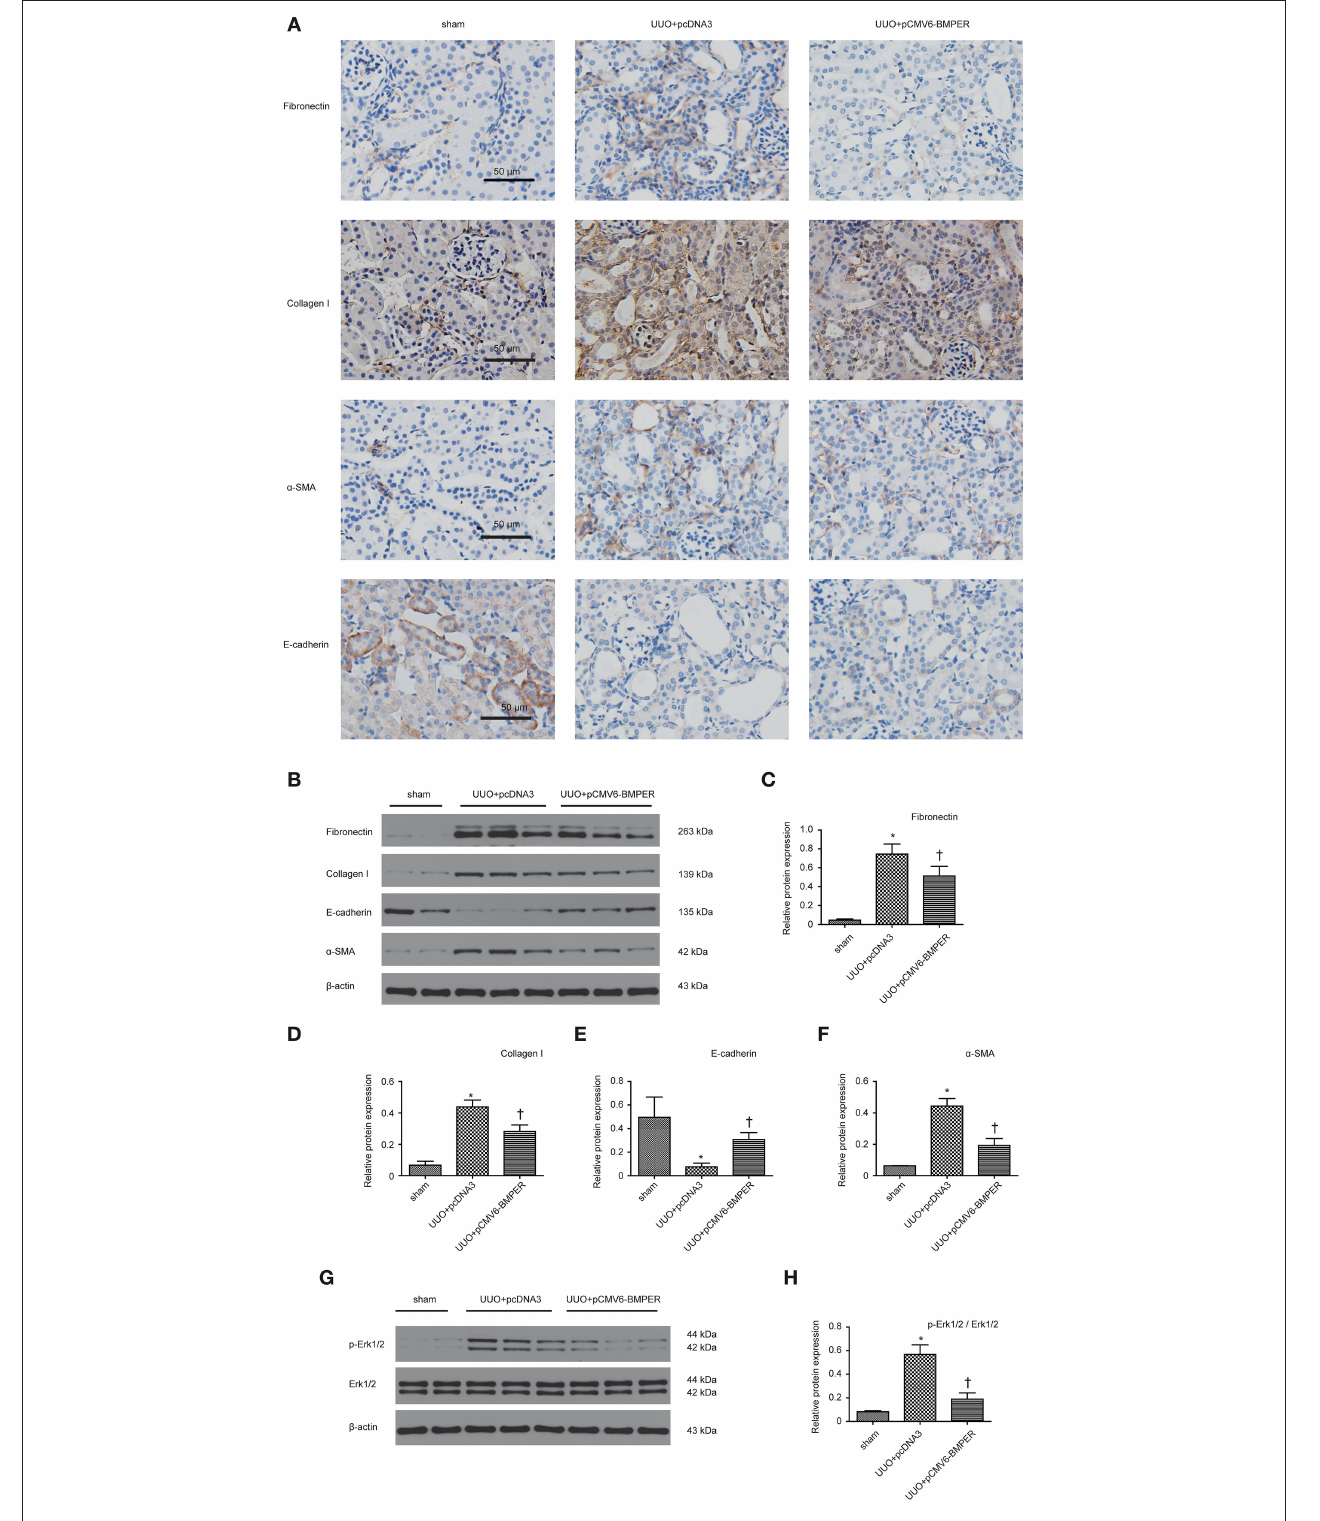
FIGURE 9 | BMPER changed levels of fibrosis-related indicators. Immunohistochemical staining for fibronectin, collagen I, E-cadherin and α -SMA in kidneys was displayed (A) . Protein expression for fibronectin, collagen I, E-cadherin and α -SMA in kidneys was measured by Western blot (B) . The relative protein expression for fibronectin, collagen I, E-cadherin and α -SMA in kidneys was displayed (C–F) . Erk1/2 and p- Erk1/2 were measured by Western blot (G) . The relative protein expression for p-Erk1/2 / Erk1/2 in kidneys was displayed (H) . Scale bar = 50 µ m. Values are the means ± SEM ( n = 6). * p < 0.05 vs. sham; † p < 0.05 vs. UUO +